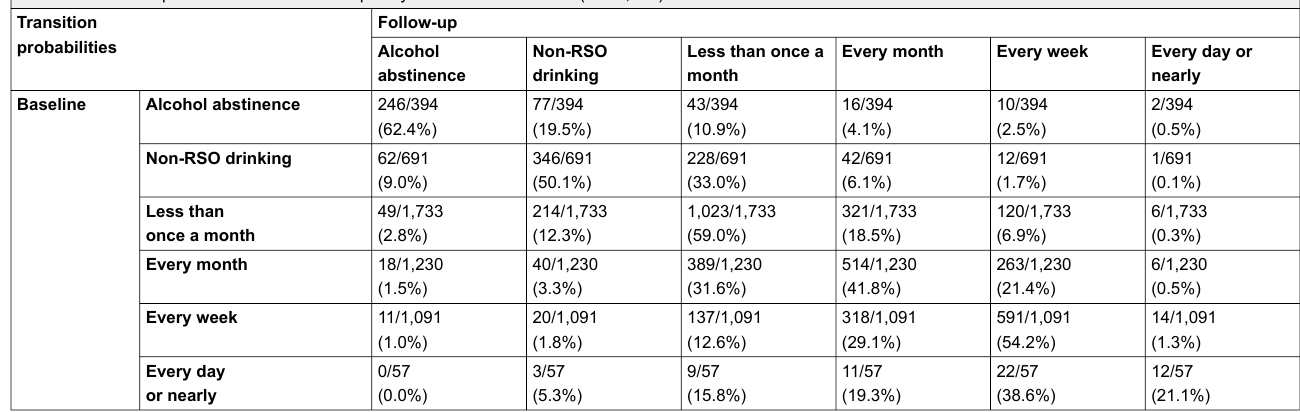
Table 2: Transition probabilities for RSOD frequency after list wise deletion (N = 5,196). Follow-upTransition